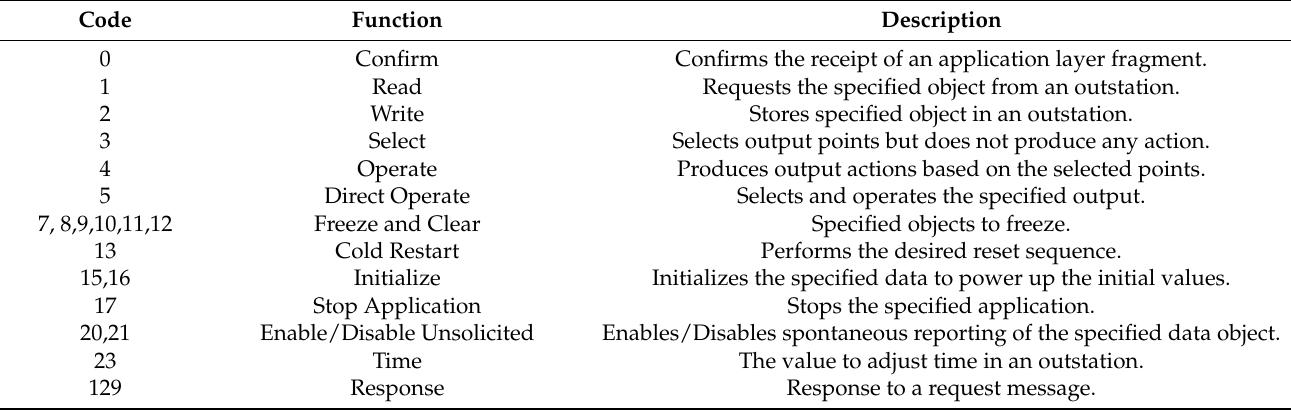
Table 1. DNP3 function codes used in the study.